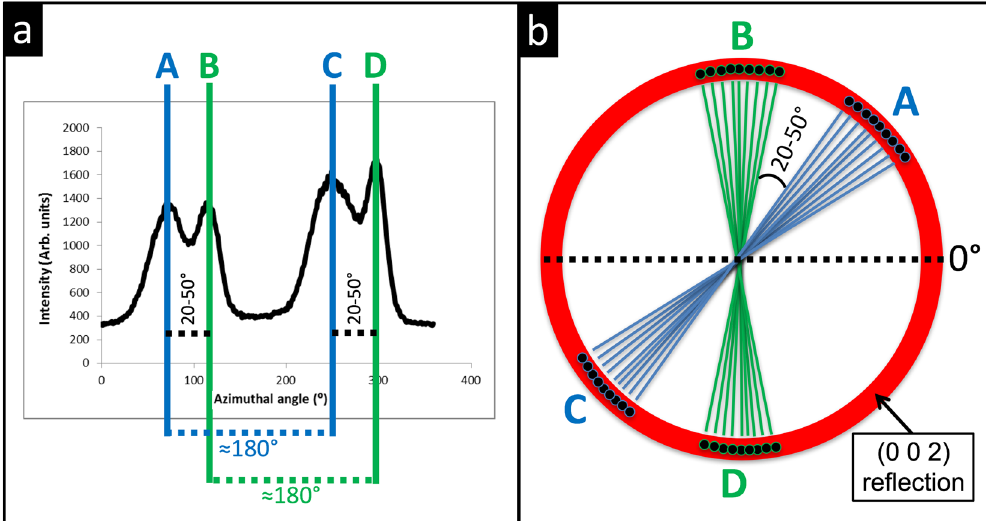
Figure 12. ( a ) A typical (002) reflection curve displaying the variations in intensity around the (002) reflection. Peaks A and C are separated by approximately 180°, as with peaks B and D . Peaks A and B and peaks C and D are separated by 20–50°. ( b ) A schematic showing the two orientation populations of crystallites, where peaks A and C represent the first population and peaks B and D represent the second population with an angular separation of 20–50° between them.